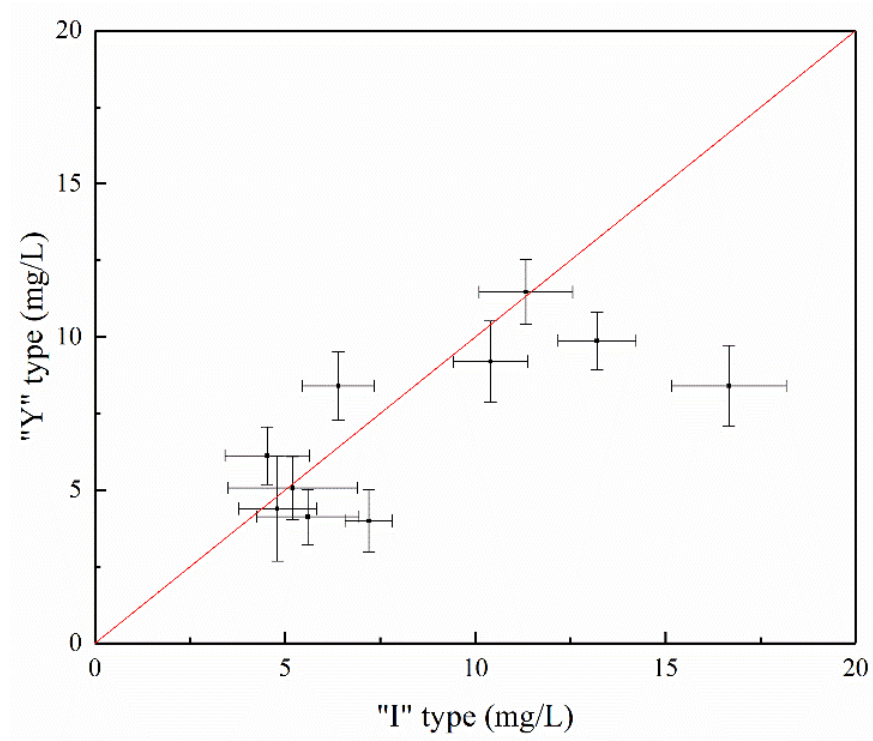
Figure 4. Total phosphorus concentration at the same position on different types of plants.